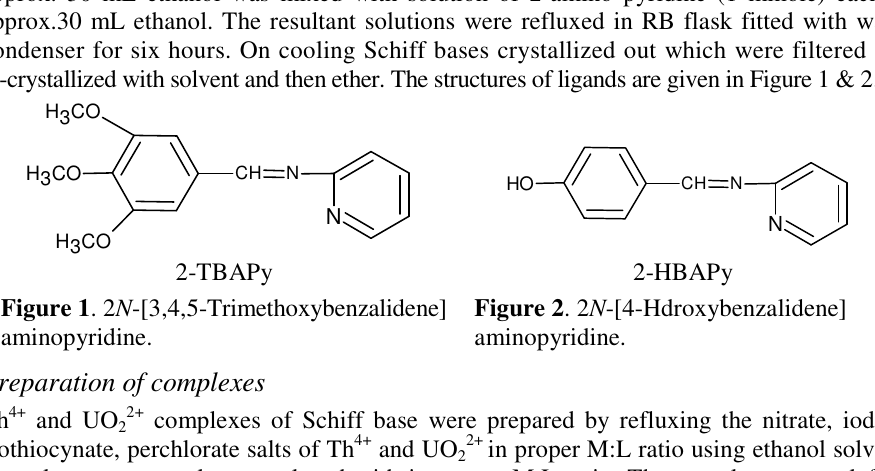
Figure 1 . 2 N -[3,4,5-Trimethoxybenzalidene] aminopyridine.